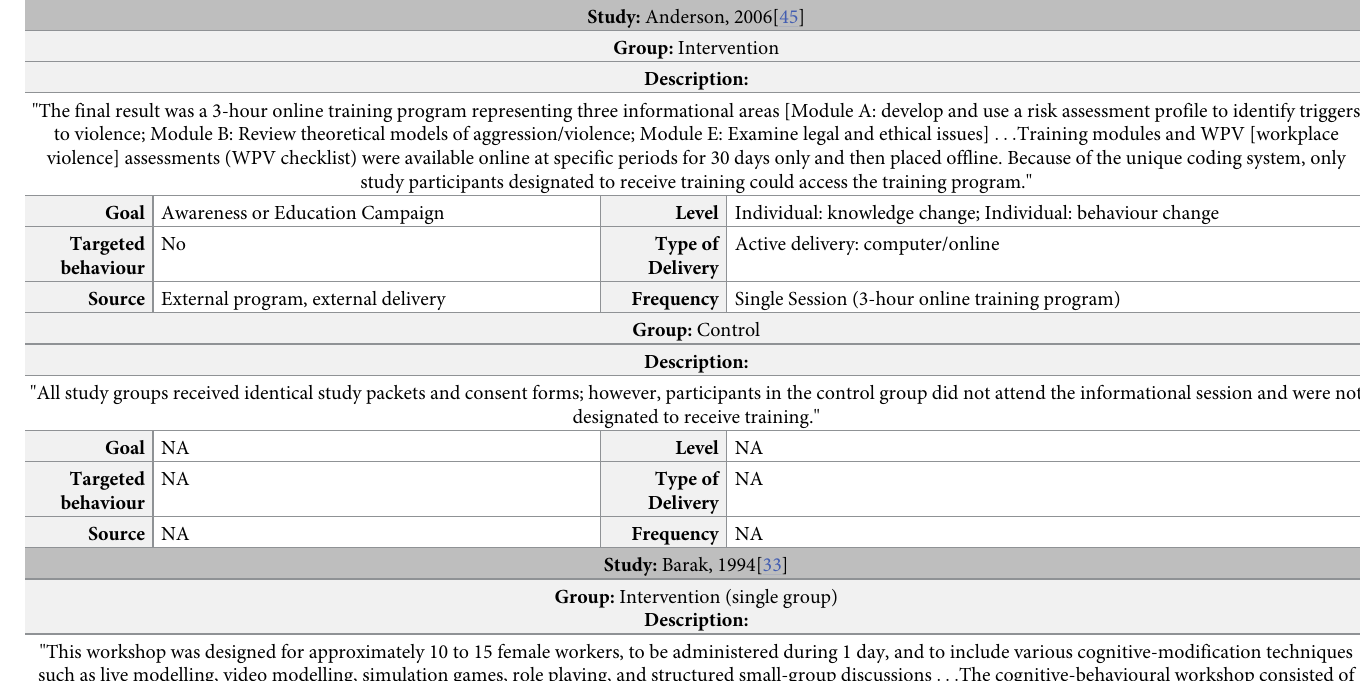
Table 2. Intervention